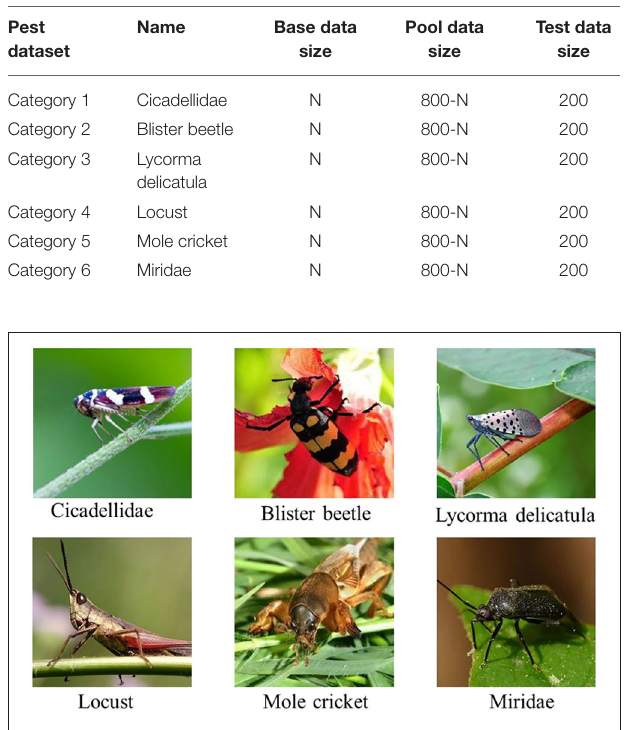
FIGURE 1 | Some image samples of the pest